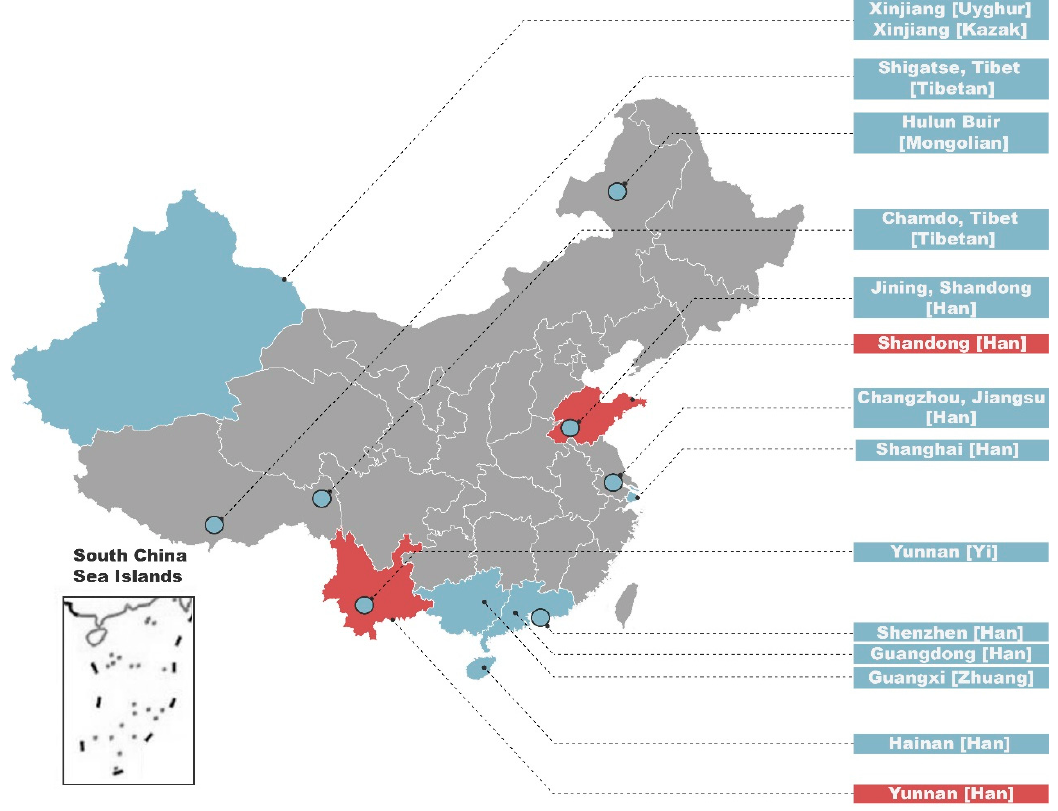
Figure 1. Geographic localizations of the 15 Chinese populations analyzed or referenced. The two populations reported in this study are indicated in red, whereas the other 13 referenced populations in the analysis of molecular variance (AMOVA) are indicated in